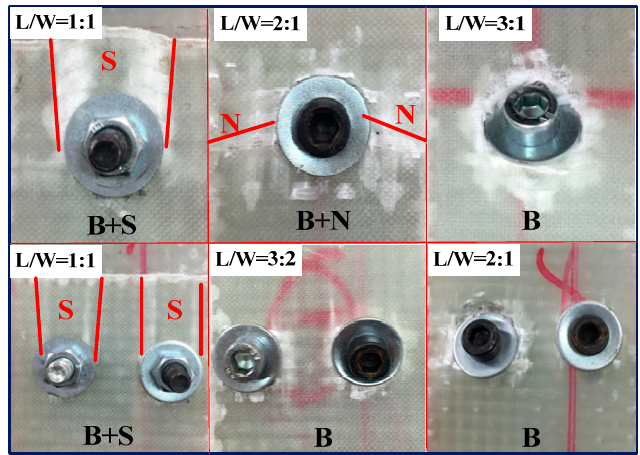
Figure 9. Damage modes of the composite bolted joints before completely failure after tensile test (In this figure, N indicates net-tension, S indicates shear out, and B means bearing failure mode).